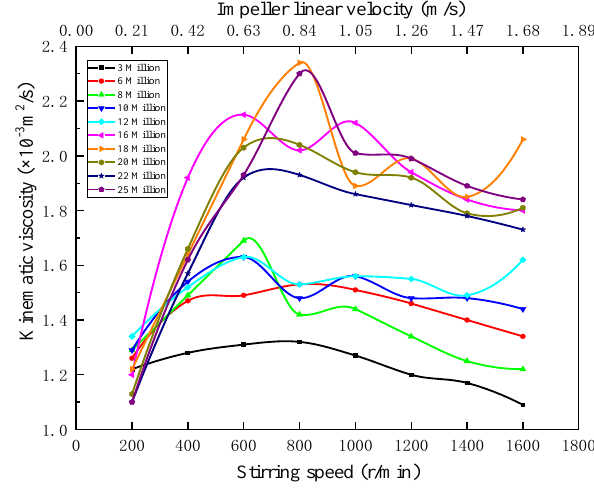
Figure 2. Kinematic viscosity versus stirring speed.